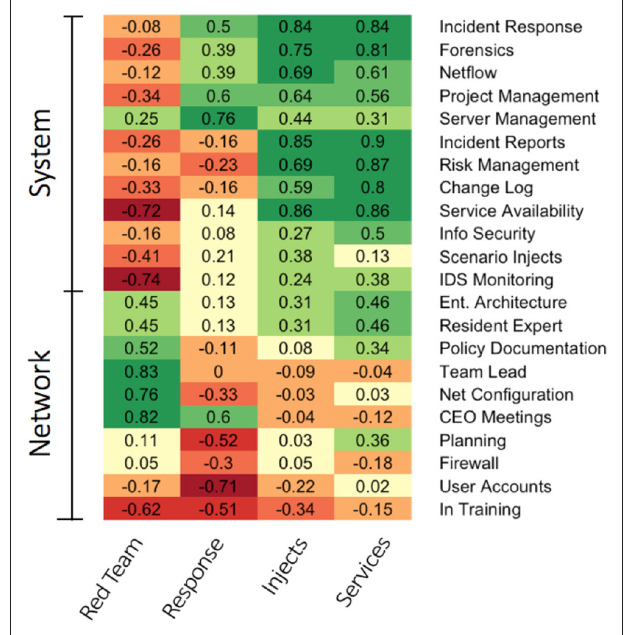
FIGURE 6 | Heatmap representation depicting the skill composition of the various cybersecurity